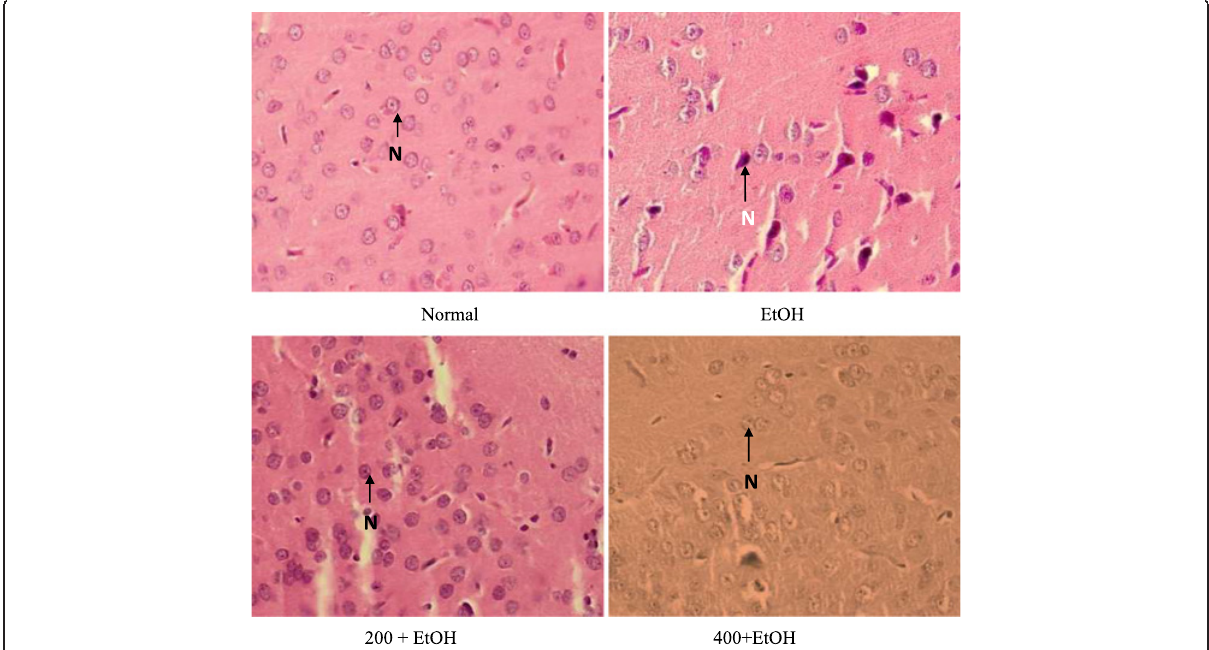
Fig. 4 Brain sections (cerebral cortex) from each group (magnification X40). Note the number and shape of neuron cells. (N-Neuron cell). ( N = 6). (EtOH: ethanol; 200 + EtOH: 200 mg/kg extract + ethanol; 400 + EtOH: 400 mg/kg extract +